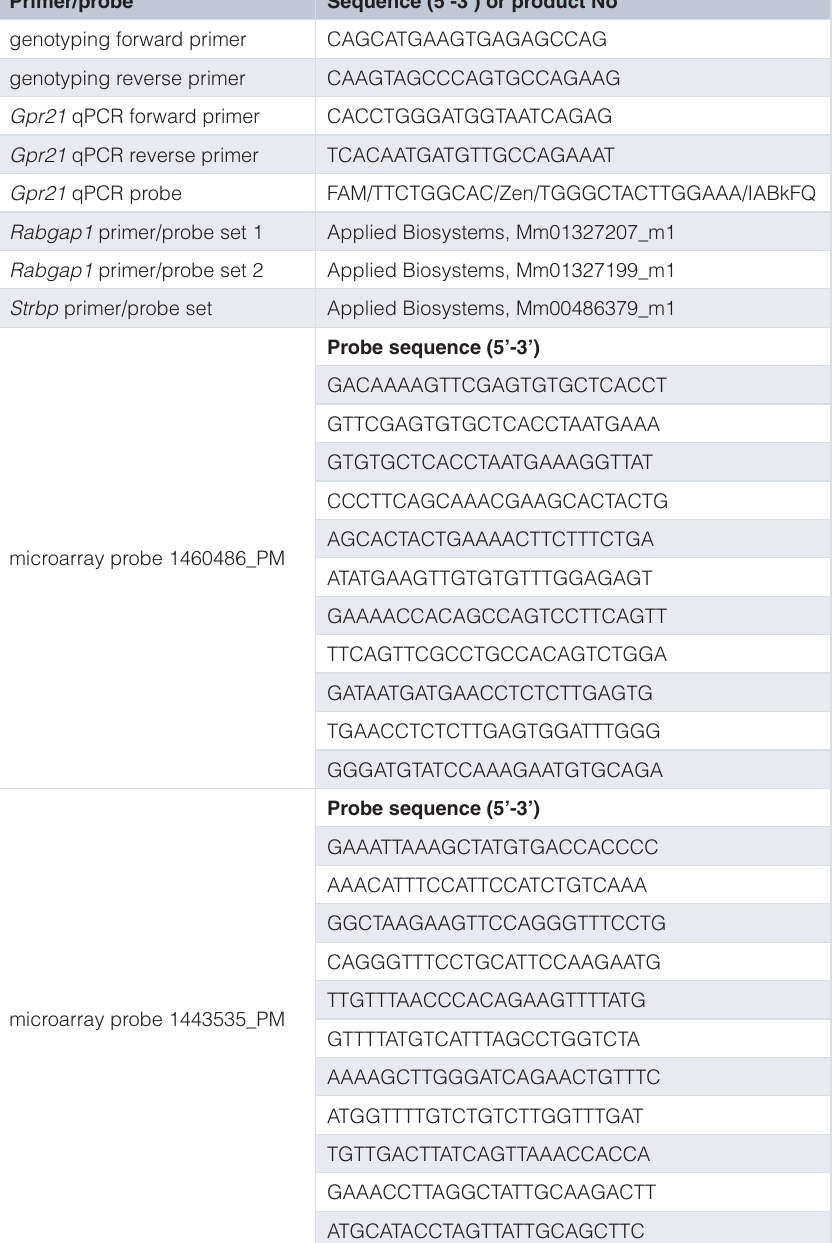
Table 1. Sequences of the different probes